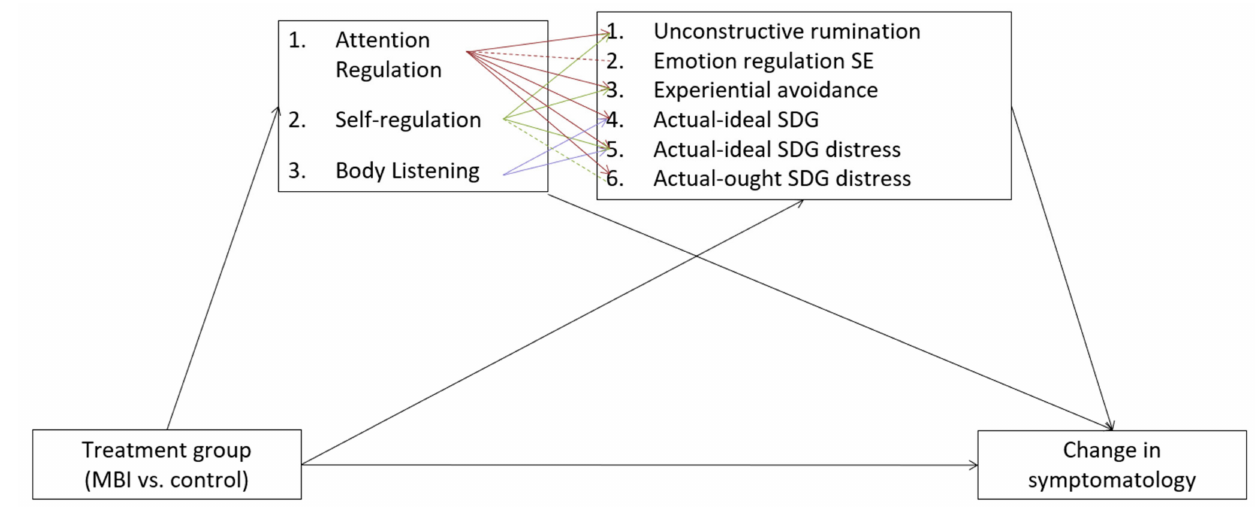
Figure 2. A summary of the multiple mediator models of the effects of treatment on symptoma- tology through body awareness (as measured by the MAIA) and transdiagnostic psychological processes as described in Section 3.5.2. All variables indicate changes in the variable (pre- and post-change scores). Dashed lines indicate associations that were not robust in the sensitivity analysis. SDG = self-discrepancy gap; SE =